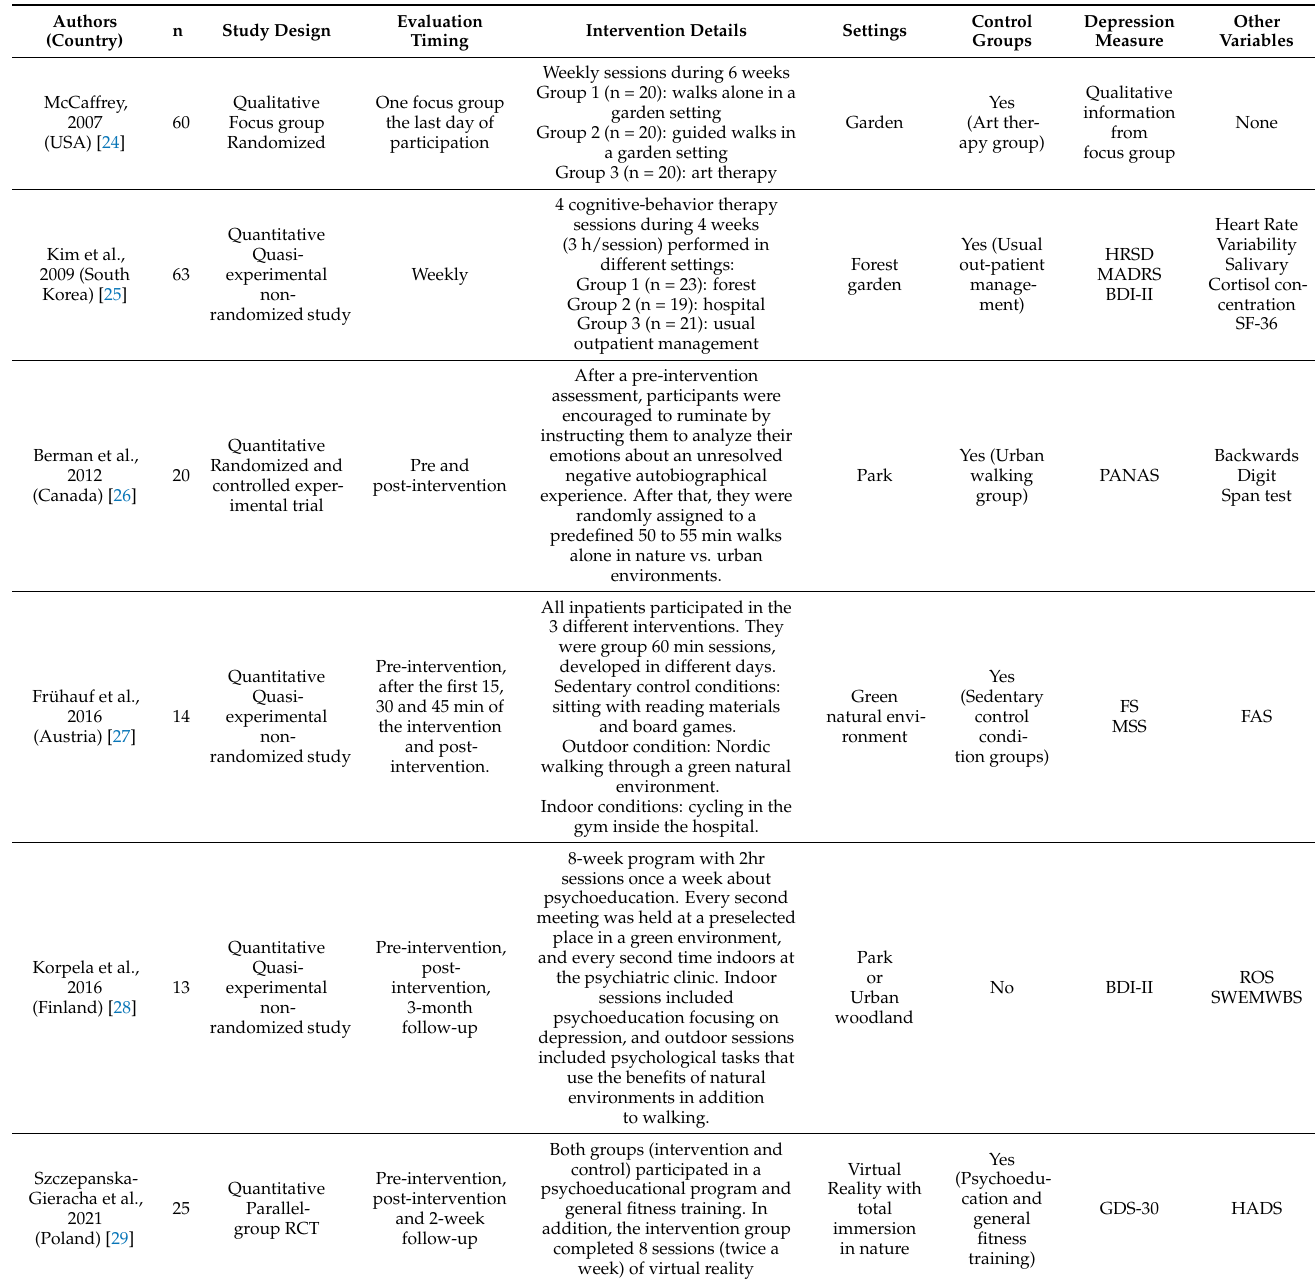
Table 1. Main characteristics of the studies that included samples of patients with clinical depres- sion